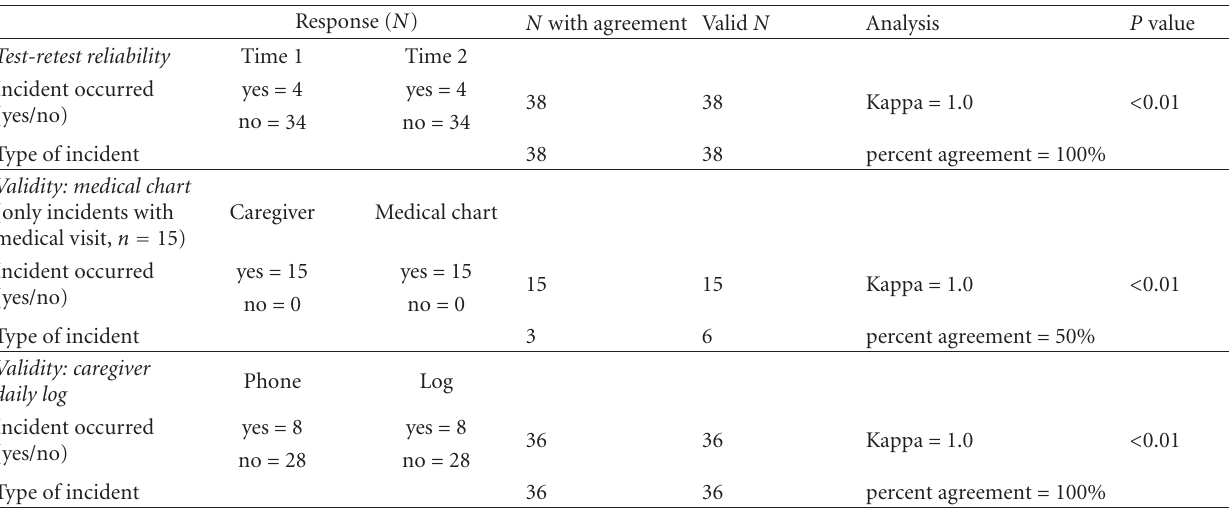
Table 2: Test-retest reliability and validity of Incidents of Harm Questionnaire.